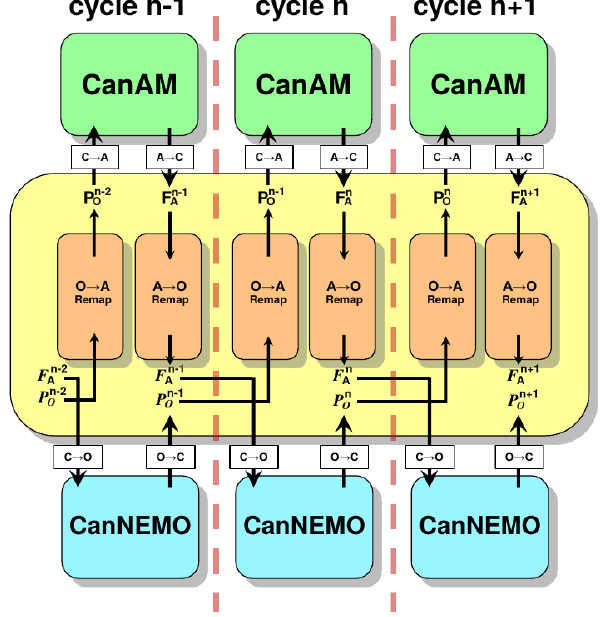
Figure A1. Schematic showing the ordering of exchanges be- tween CanCPL and CanAM and CanNEMO. Prognostic fields ( P O ) are passed from NEMO to the coupler, remapped, and passed to CanAM. Fluxes ( F A ) are passed from CanAM, remapped in Can- CPL, and passed NEMO to complete the next coupling cycle. Su- perscripts denote the coupling cycle; e.g. prognostic fields from NEMO are passed to CanCPL at the end of cycle “ n ”, remapped, and used in CanAM during cycle “ n + 1”.